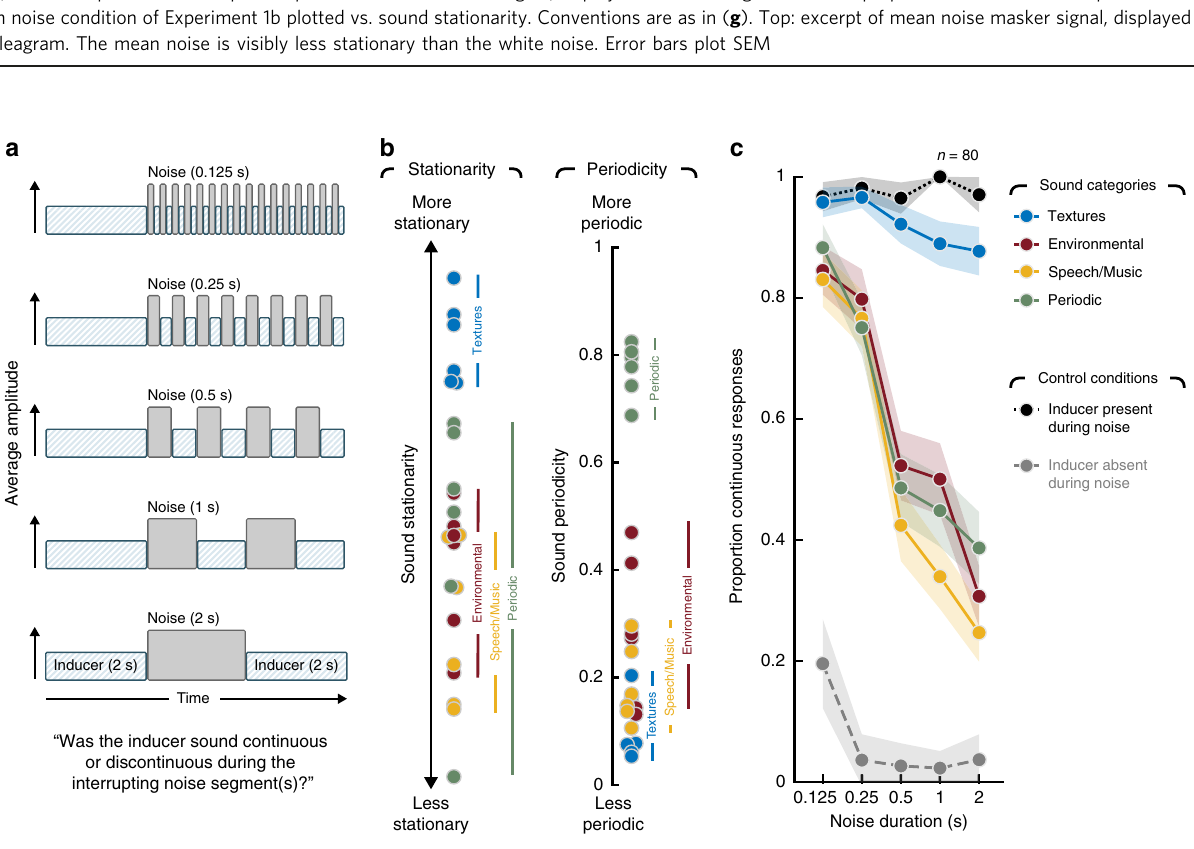
Fig. 3 Experiment 2 — illusory continuity across masker durations. a Schematic of stimulus conditions in Experiment 2. b Stationarity and periodicity of sounds used in the experiment. Each data point plots the stationarity or periodicity of an individual real-world sound recording used as an inducer sound in Experiment 2 (dot color denotes the four sound categories). c Results for Experiment 2. Control conditions show results when the inducer was physically present or absent during the interrupting noise segment(s) (same as control conditions of Experiment 1; see Fig. 2b for schematics). Shaded region